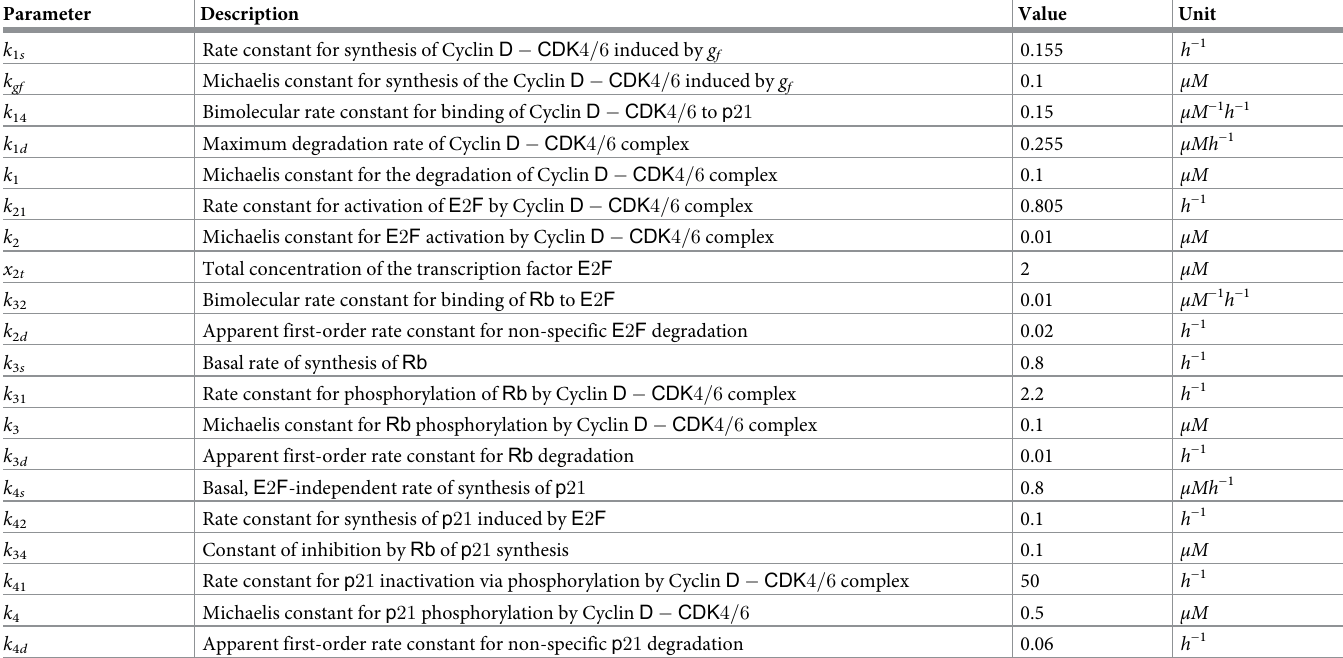
Table 2. Parameters of cell-cycle model, [25]. Here μM and h represents micromolar and hour, respectively. Parameter Description Value Unit